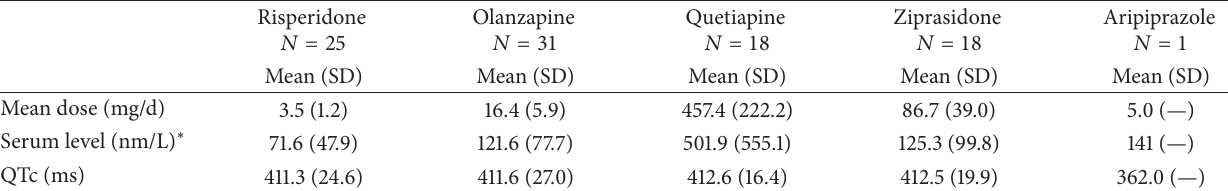
Table 2: Antipsychotic drug use and QTc intervals at discharge/6